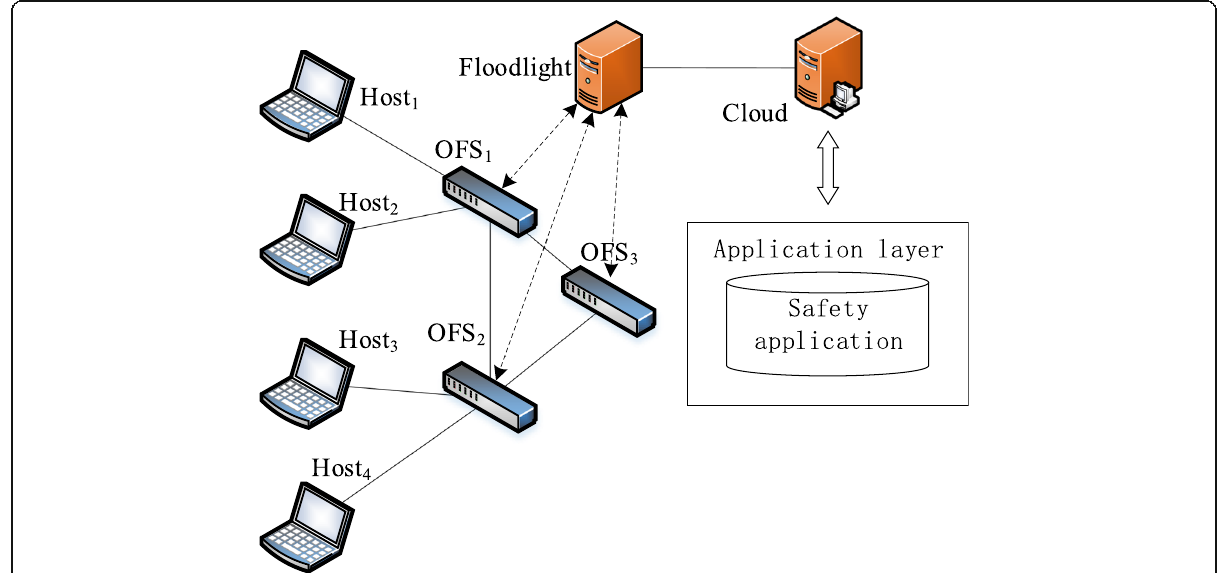
Fig. 4 Experimental edge-cloud environment topology